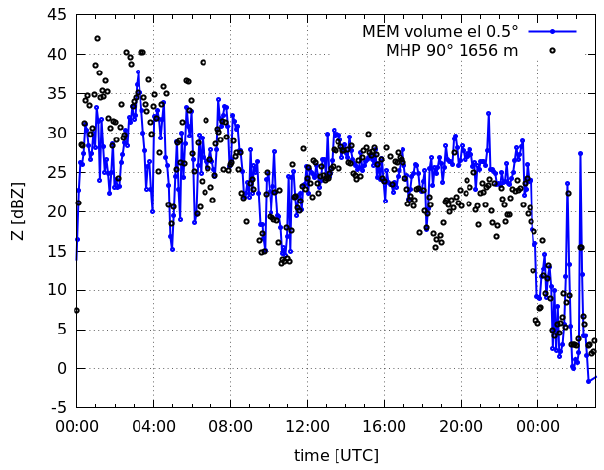
Figure 15. Time series of the reflectivity factor from the first far field range bin (about 650m above the site) of the birdbath scan at MHP and the MHP range bin from 0.5 ◦ elevation of the MEM radar. Data are from 5 January 2013, 00:00UTC, until 6 January 2013, 03:00UTC.